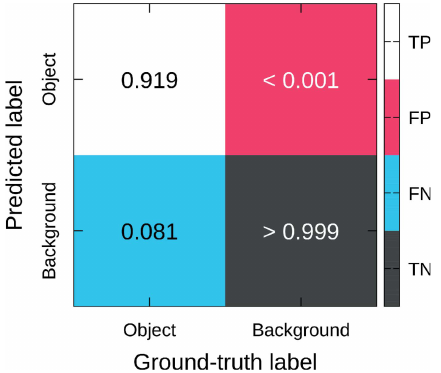
Figure 4 Normalized confusion matrix for the test set. TP: true positive; FP: false positive; FN: false negative; TN: true